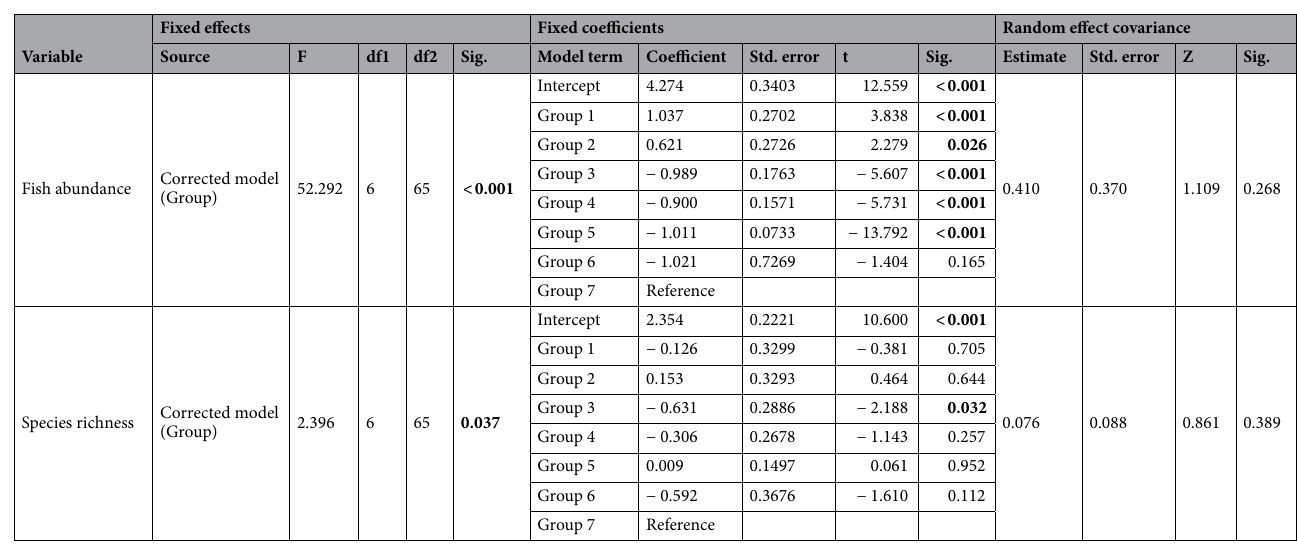
Table 3. Generalized linear mixed-effects model (GLMM) for the effect of elevation on fish abundance and species richness (n = 72). Sampling time was included as a random factor in the model. Significant value ( p value < 0.05) was indicated in